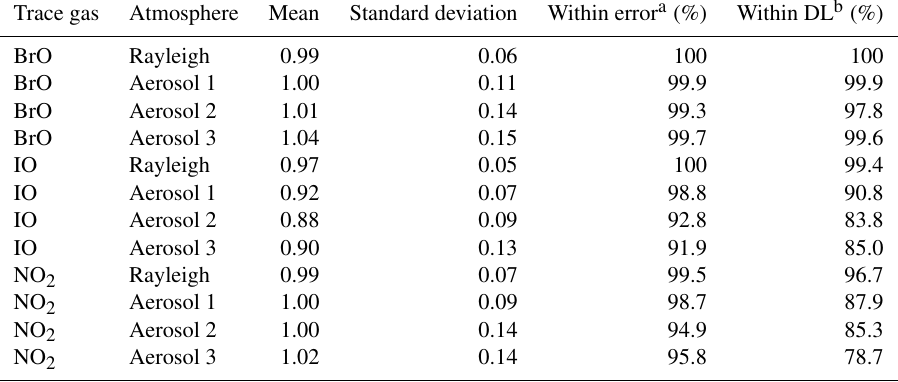
Table 2. VMR retrieval results for synthetic